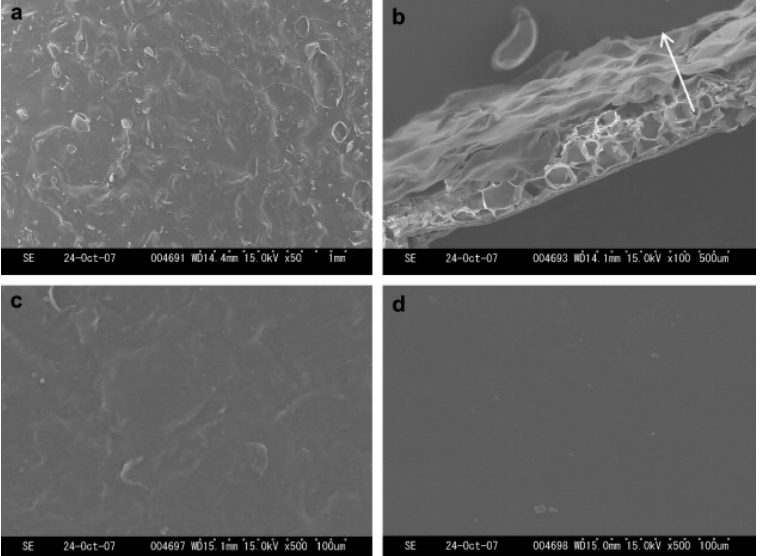
Figure 5. SEM micrographs of α -chitin samples obtained with [Bmim][Ac] as solvent: ( a ) surface and ( b ) cross-section of freeze-dried sponge, ( c ) surface of oven-dried film with methanol as anti-solvent, and ( d ) surface structure of oven-dried film with water as anti-solvent. Reprinted with permission from [78].